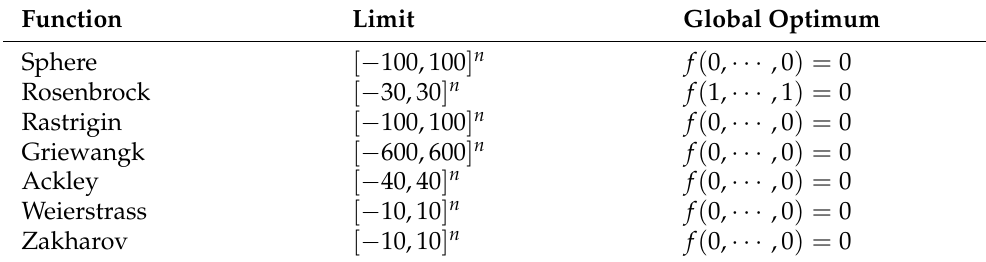
Table 3. Limits and global optima of the benchmark